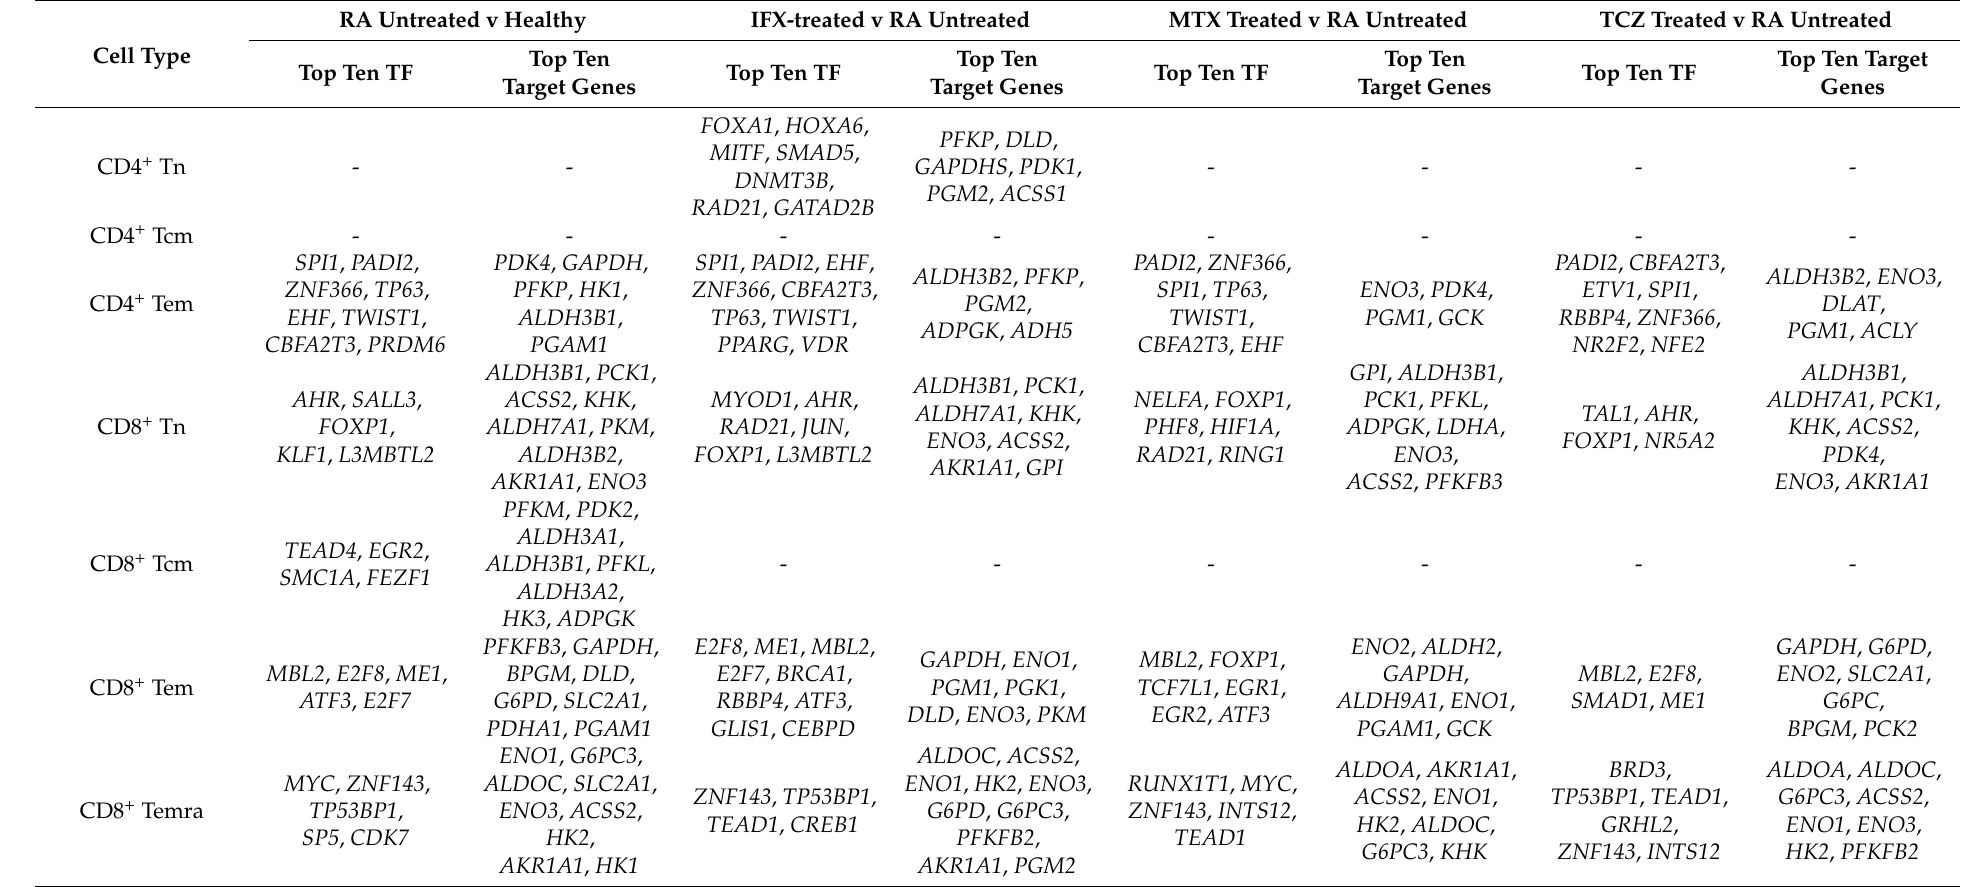
Table 15. Top transcription factors and target genes in GTRD-annotated transcription factor–target gene network of untreated RA and treated RA T cell